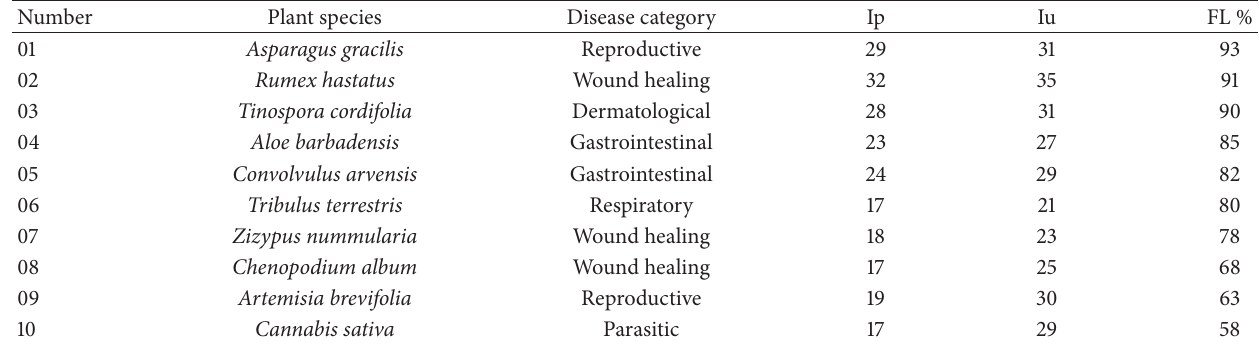
Table 4: Fidelity level of highly utilized